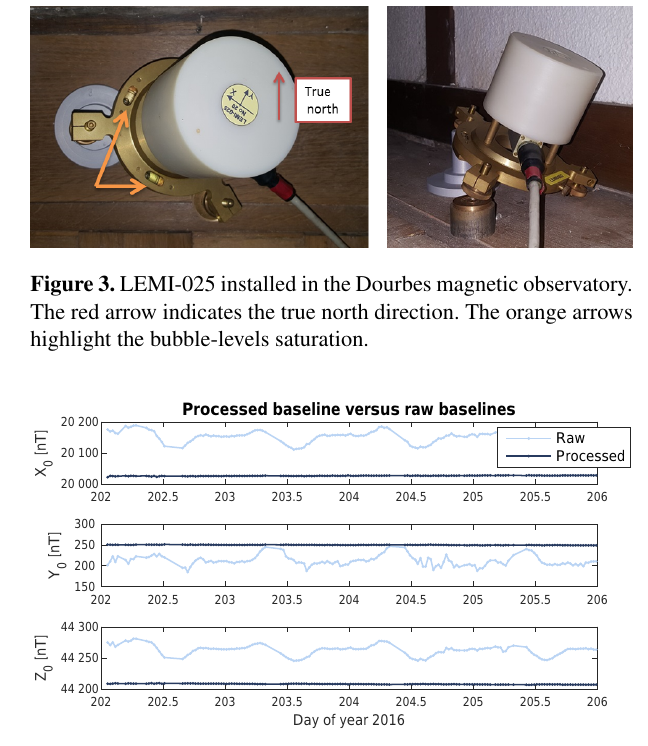
Figure 4. LEMi-025 baselines. Light blue: before processing. Dark blue: after processing.